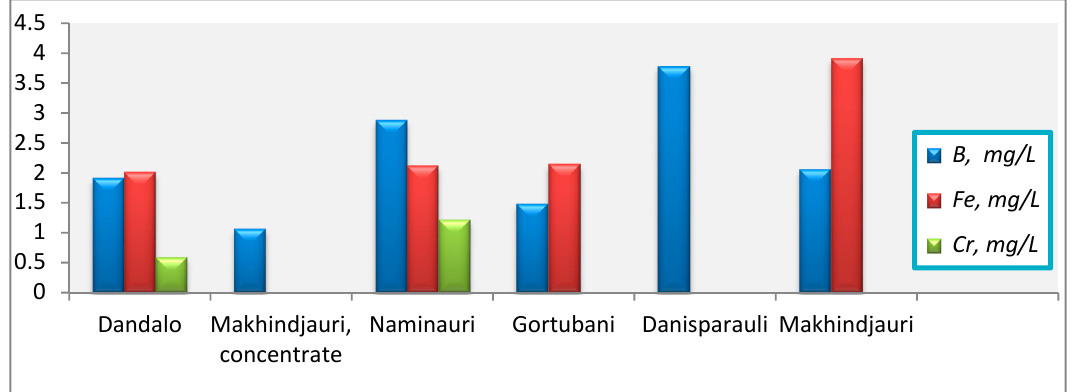
Figure 9. The content of B , Fe and Cr in the Adjarian and Adigeni regions mineral waters.